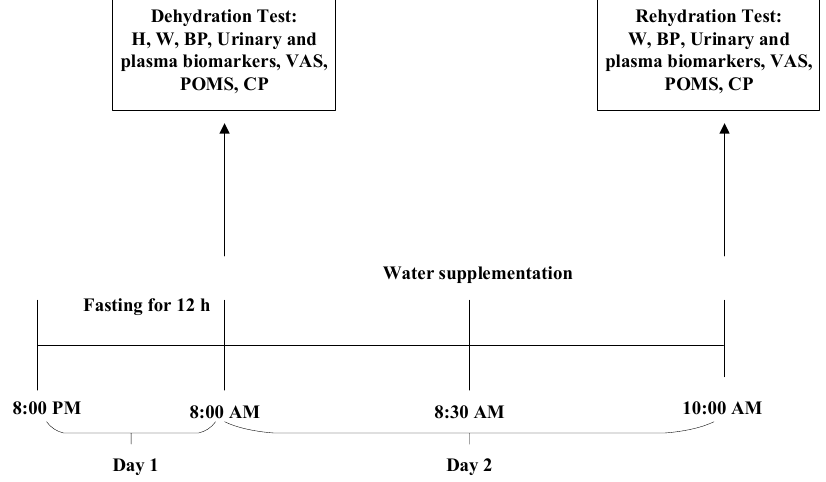
Figure 2. The study procedure. H (Height); W (Weight); BP (Blood Pressure); VAS (Visual Analogue Scales); POMS (Profile of Mood States); CP (Cognitive Performances).